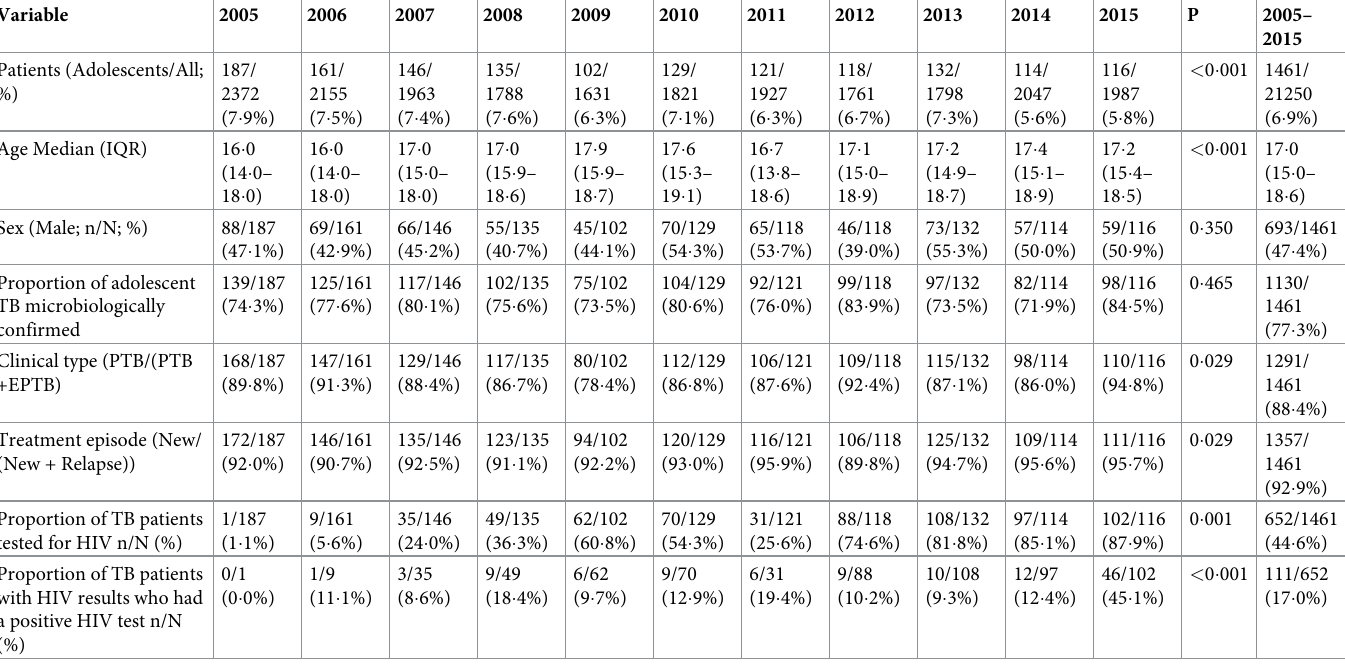
Table 1. Demographic and clinical characteristics of adolescent TB